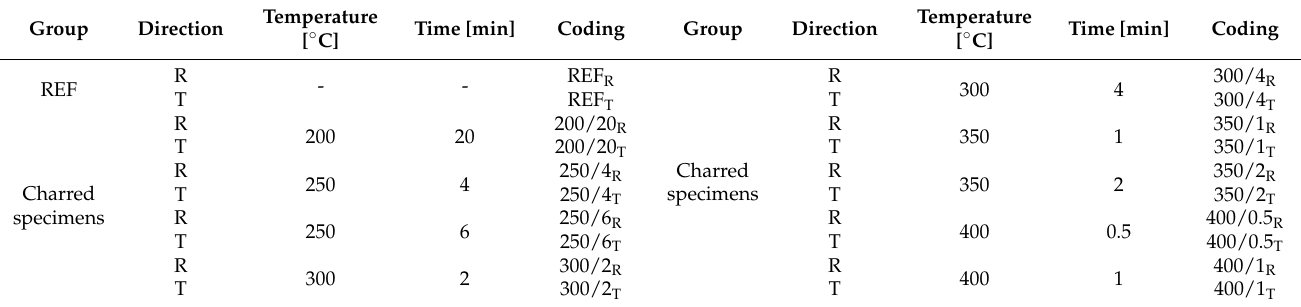
Table 1. Coding of specimens referring to the direction, temperature and time of charring.